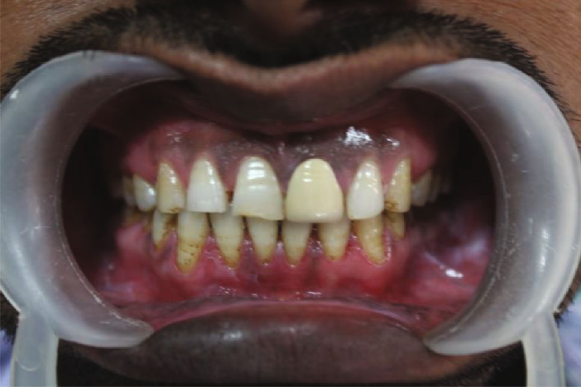
Figure 5: Postop